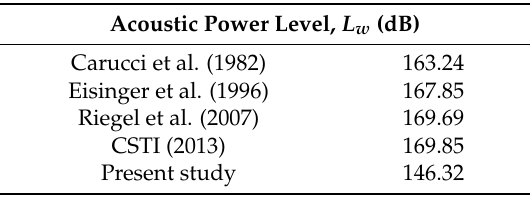
Figure 16. Power level spectrum of each mode. Table 1. Overall acoustic power levels found using empirical formulas.